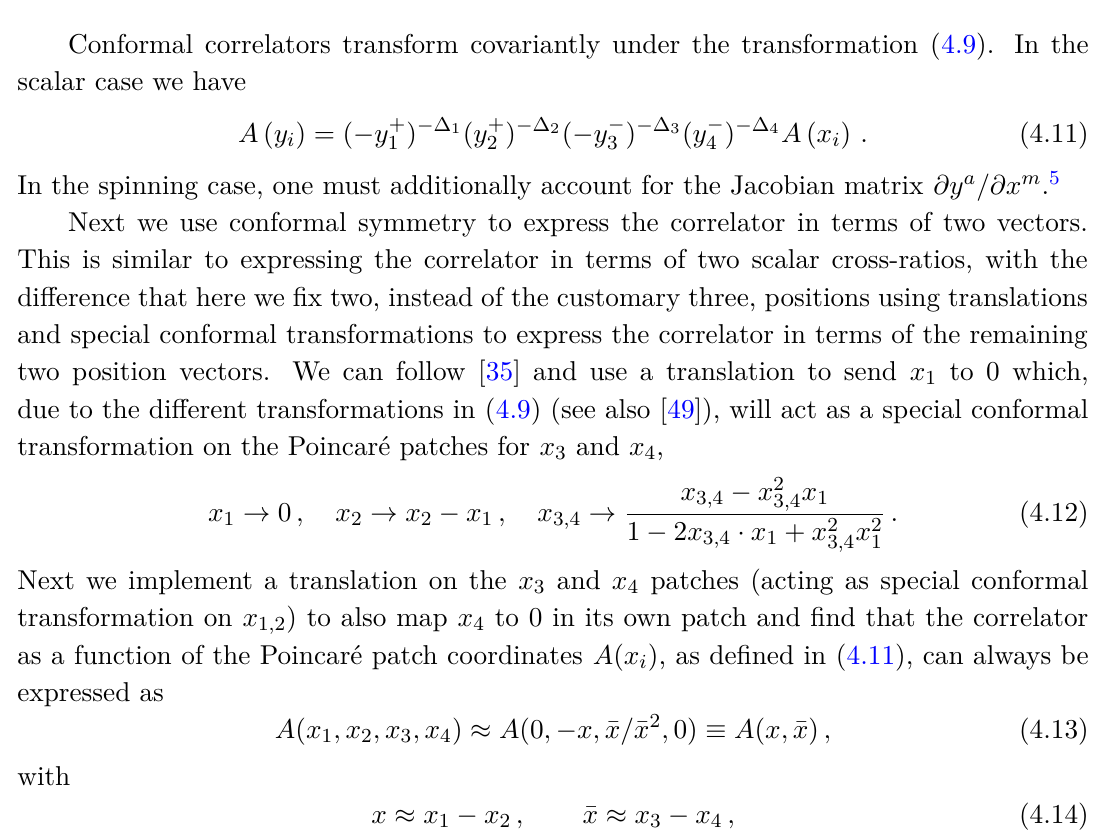
Figure 5 . The external operators at coordinates x i in their respective Poincaré patches P i . The black dotted lines are identified when the Poincaré patches are wrapped on the boundary of the global AdS